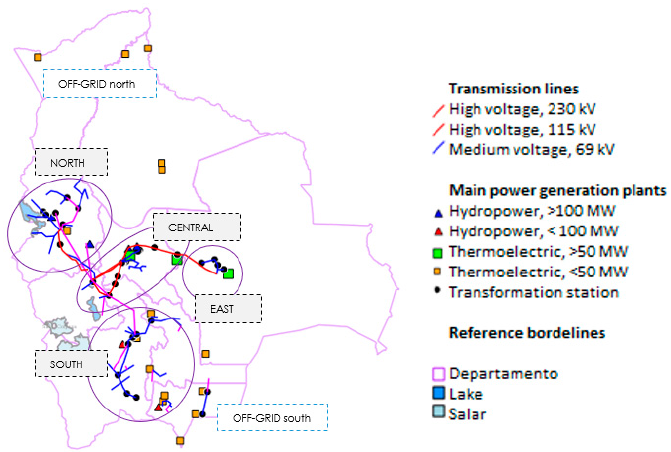
Figure 1. Geographical representation of the energy model and sub-regional division in the current grid configuration.